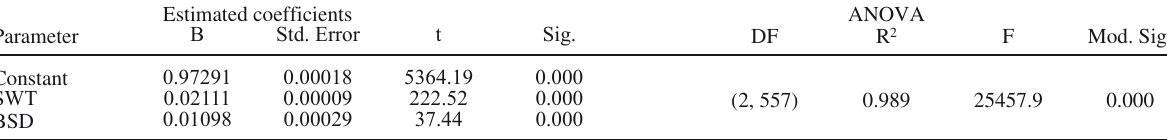
Table 2. – Estimated coefficients (B) and Standard Error (Std. Error) of Generalized Linear Model (GLM) routines, applied to the dependent measure Sound Compensation Coefficient (SCC) in function of the independent parameters sea water temperature (SWT) and bottom